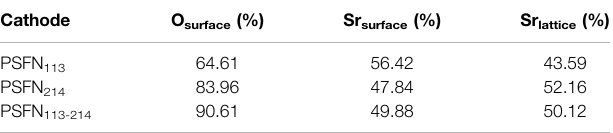
TABLE 1 | The percentage of O surface , O lattic e, Sr surface , and Sr lattice in PSFN 113 , PSFN 214 , and PSFN 113-214 (5:5). Cathode